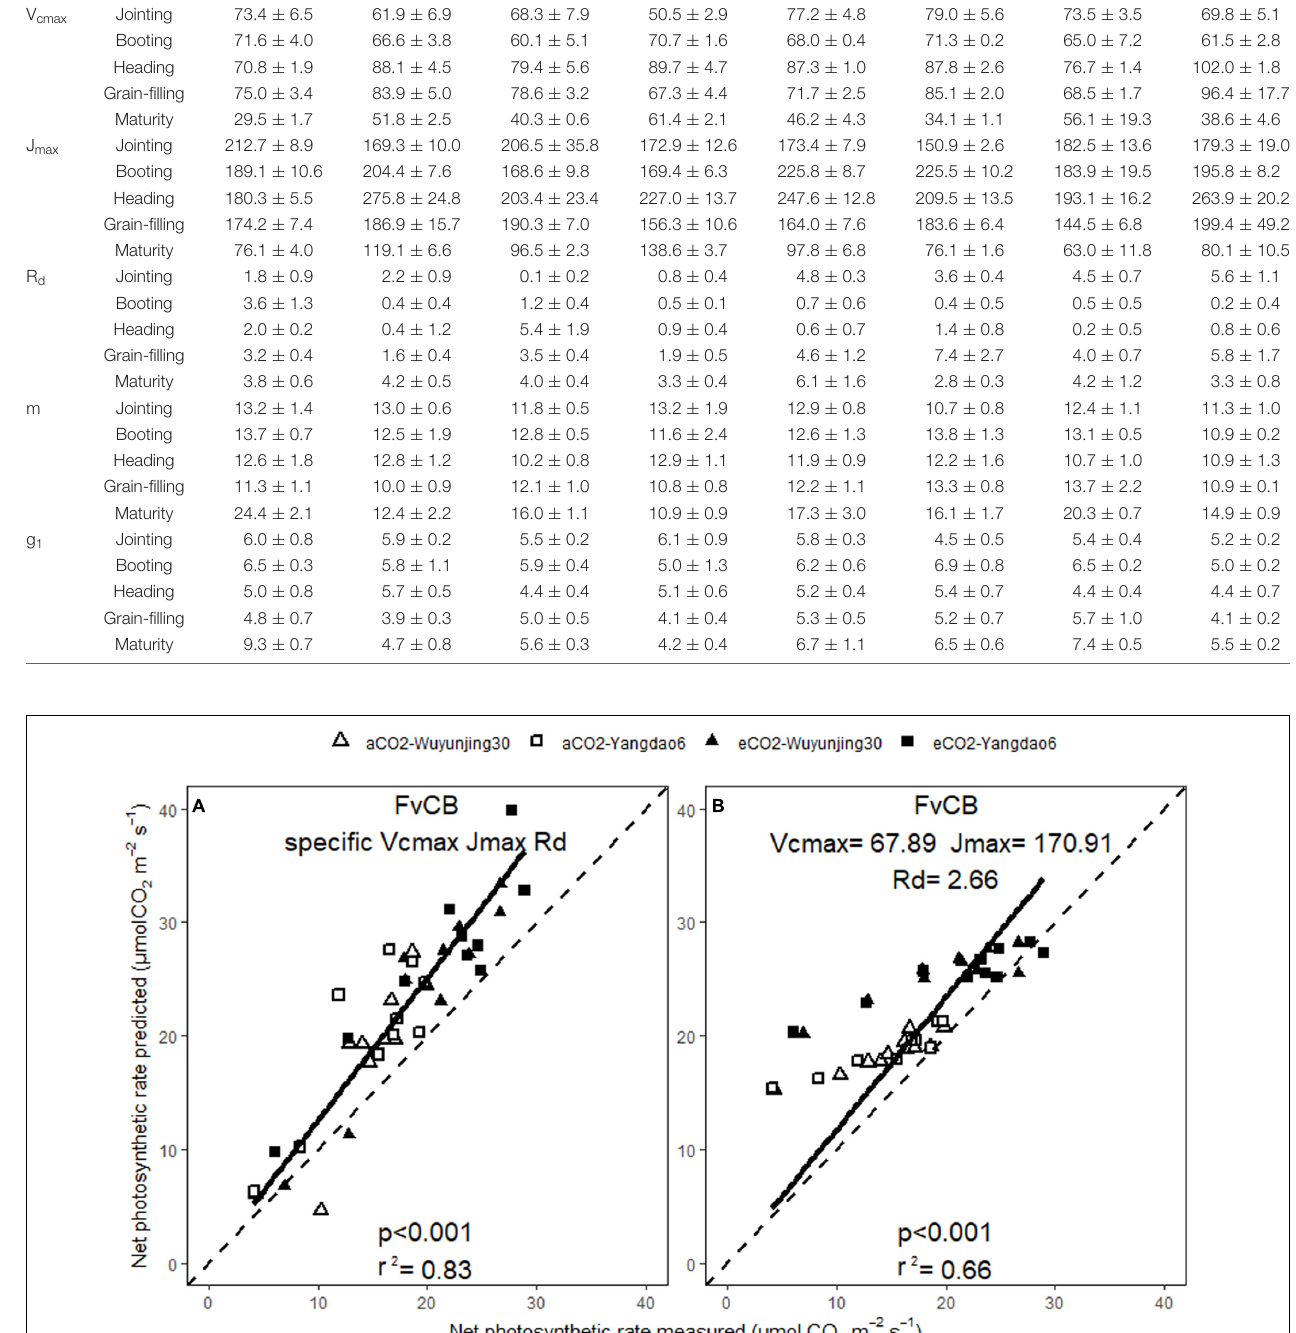
Frontiers in Plant Science |